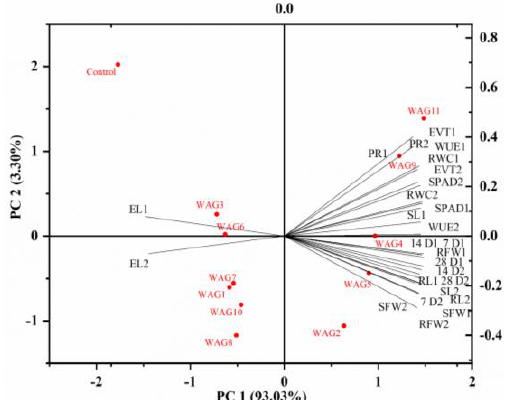
Figure 3. Principal components analysis showing positive and negative correlations between eleven different bacteria and parameters in the experiments with 100 and 200 mg/kg glyphosate. 7 D1 = degradation of glyphosate after 7 days at 100 mg/kg, 14 D1 = degradation of glyphosate after 14 days at 100 mg/kg, 28 D1 = degradation of glyphosate after 28 days at 100 mg/kg, 7 D2 = degradation of glyphosate after 7 days at 200 mg/kg, 14 D2 = degradation of glyphosate after 14 days at 200 mg/kg, 28 D2 = degradation of glyphosate after 28 days at 200 mg/kg, SL1 = shoot length at 100 mg/kg, SL2 = shoot length at 200 mg/kg, RL1 = root length at 100 mg/kg, RL2 = root length at 200 mg/kg, SFW1 = shoot fresh weight at 100 mg/kg, SFW2 = shoot fresh weight at 200 mg/kg, RFW1 = root fresh weight at 100 mg/kg, RFW2 = root fresh weight at 200 mg/kg, PR1 = photo- synthetic rate at 100 mg/kg, PR2 = photosynthetic rate at 200 mg/kg, EVT1 = transpiration rate at 100 mg/kg, EVT2 = transpiration rate at 200 mg/kg, WUE1 = water use efficiency at 100 mg/kg, WUE2 = water use efficiency at 200 mg/kg, RWC1 = relative water content at 100 mg/kg, RWC2 = rel- ative water content at 200 mg/kg, EL1 = electrolyte leakage at 100 mg/kg, EL2 = electrolyte leakage at 200 mg/kg, SPAD1 = chlorophyll SPAD value at 100 mg/kg, SPAD2 = chlorophyll SPAD value at 200